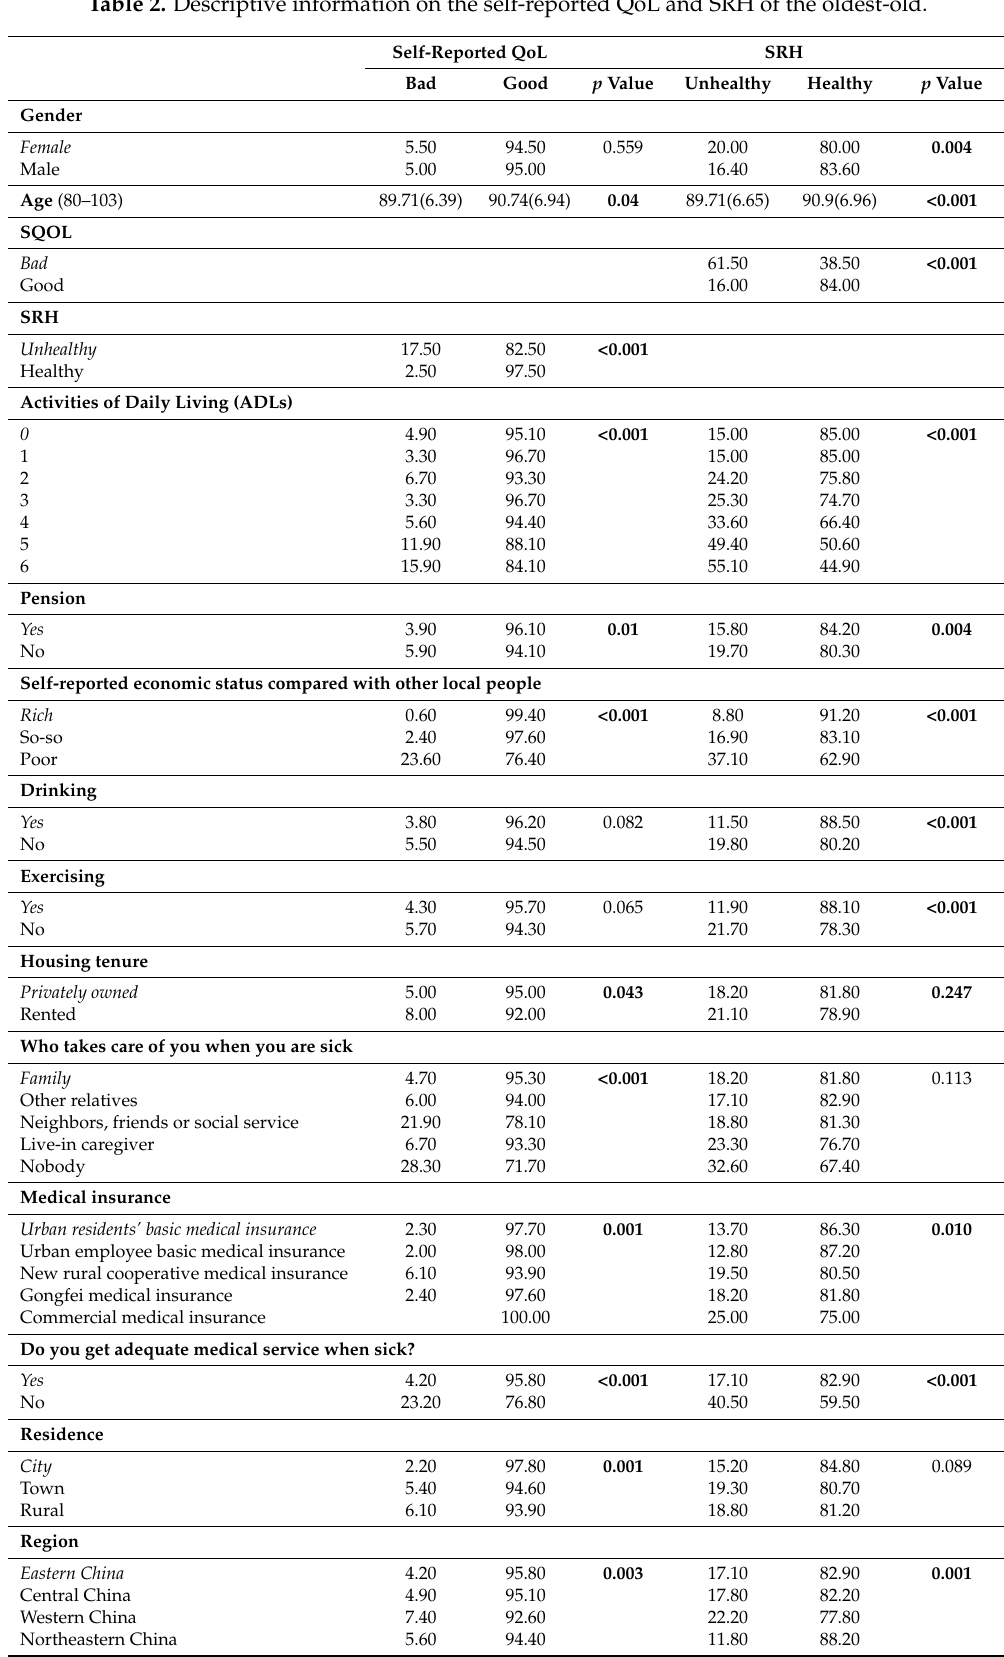
Table 2. Descriptive information on the self-reported QoL and SRH of the oldest-old. Self-Reported QoL SRH Bad Good p Value Unhealthy Healthy p